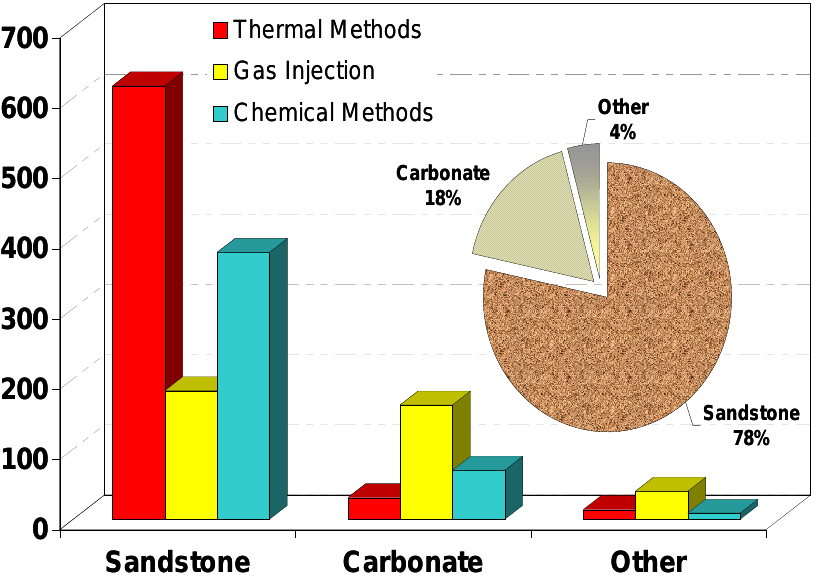
Figure 3. EOR methods by lithology (Based on a total of 1,507